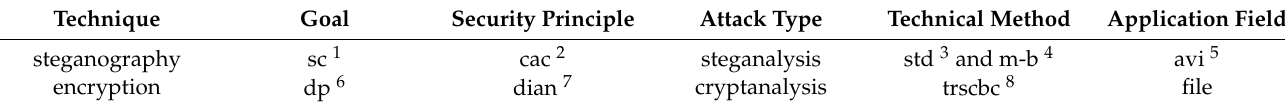
Table 1. Comparison of steganography and